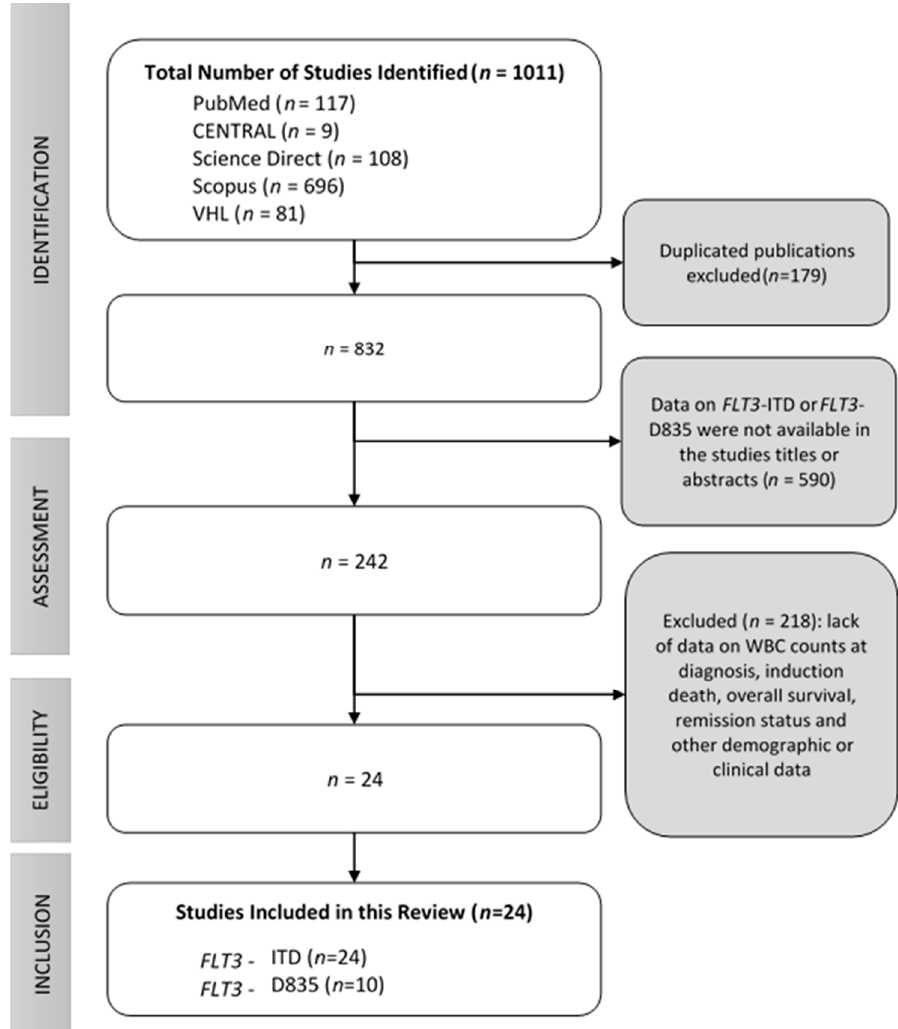
Figure 1. Flowchart to identify studies on acute promyelocytic leukemia with the acquired mutations FLT3 -ITD (internal tandem duplication) and FLT3 -D835.